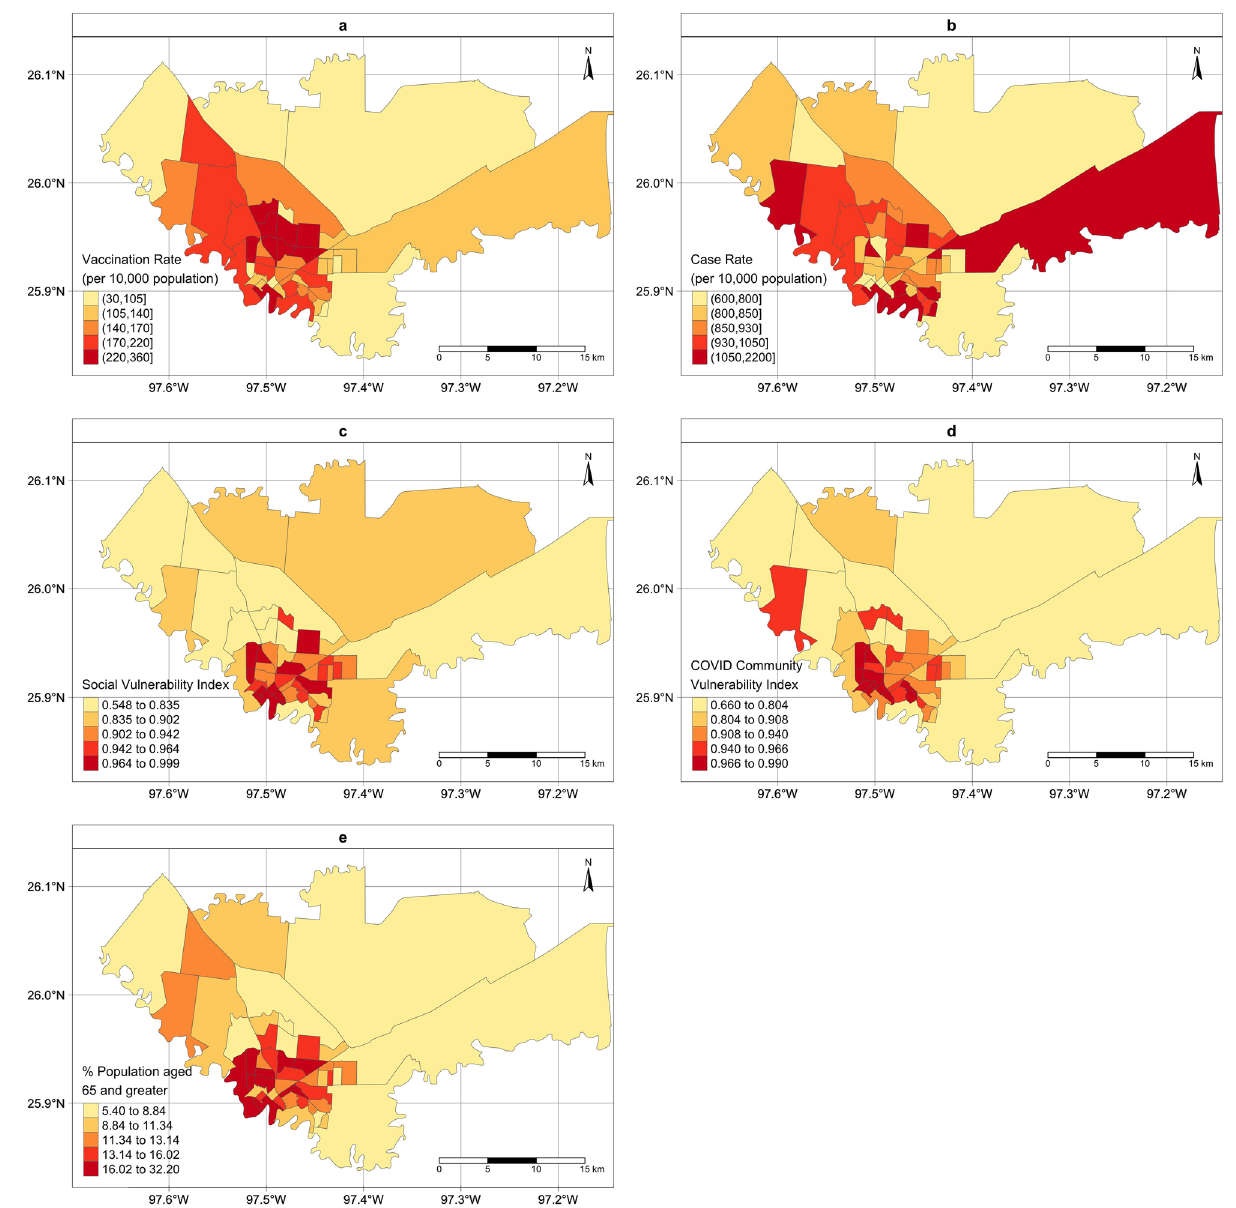
Figure 1. Maps of the census-tract level vaccination rate and vaccination priority in City of Brownsville, TX. ( a ): Vaccination rate per 10,000 population (February 5th–March 13th, 2021); ( b ): Case rate per 10,000 population (March 18th, 2020–March 13th, 2021). ( c ): social vulnerability index (SVI) ranked from 0 to 1; ( d ): COVID community vulnerability index (CCVI) ranked from 0 to 1; ( e ): percentage of population with 65 years old and over. The choropleth maps were created by the authors using R Studio (version 1.2.1335). URL http:// www. rstud io. com/, and R package